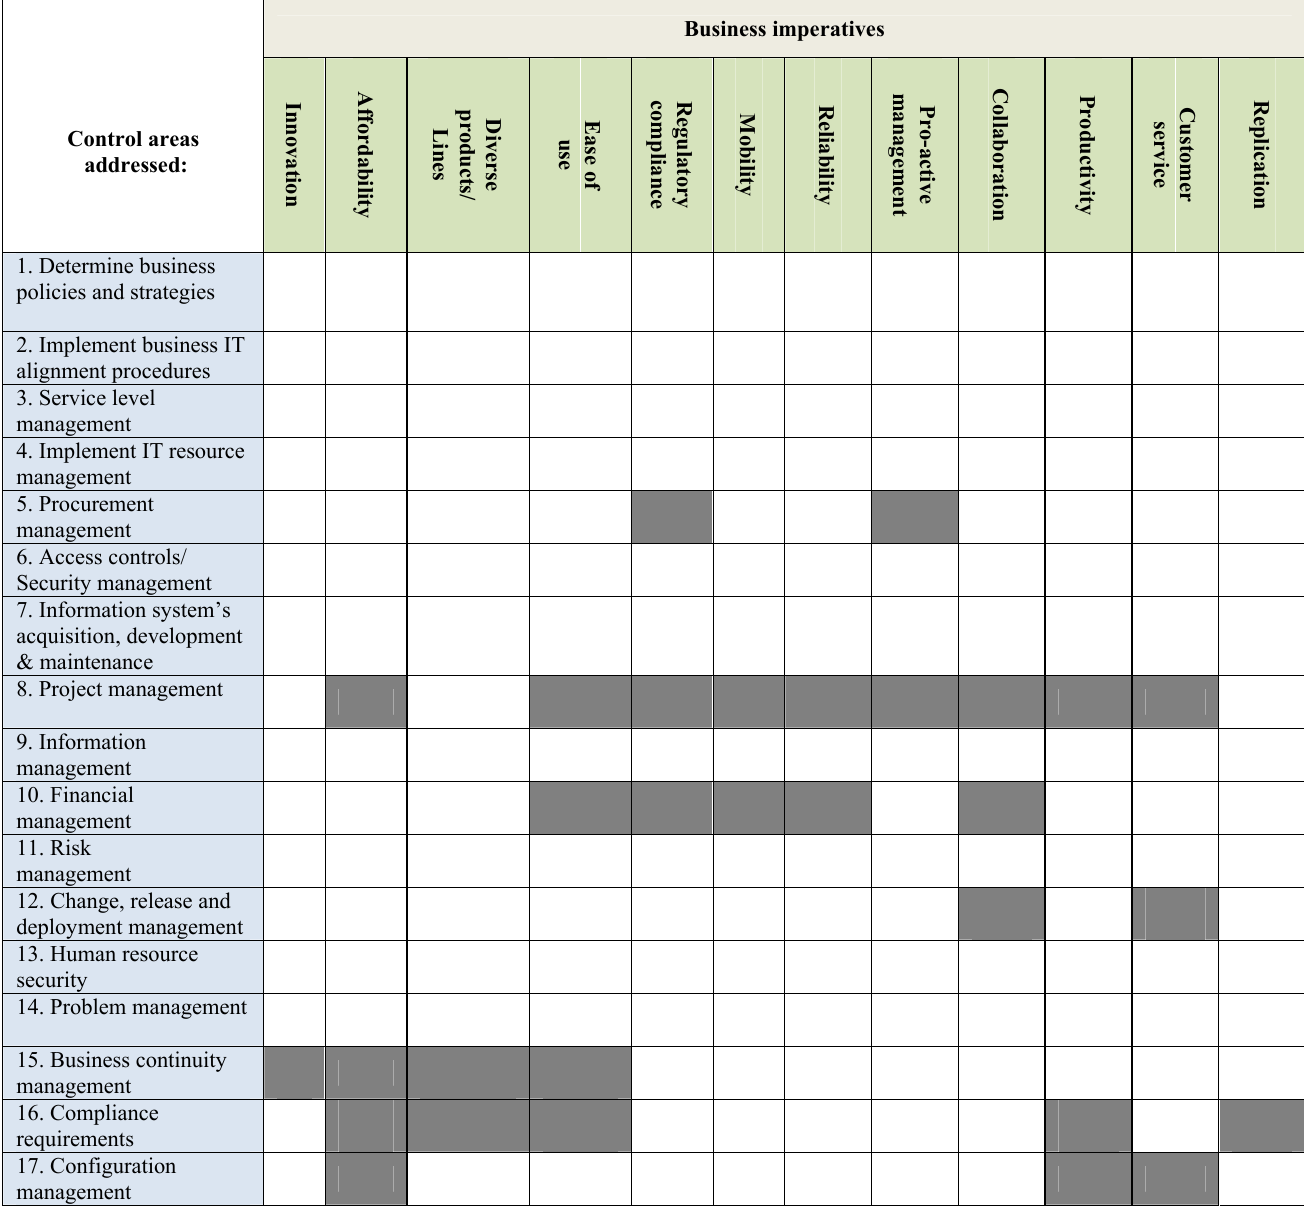
Table 1 – Results of the integrated framework: The key control areas which are addressed in combining and aligning the COBIT control framework, ITIL control model and ISO 27002 standard’s control objectives to the